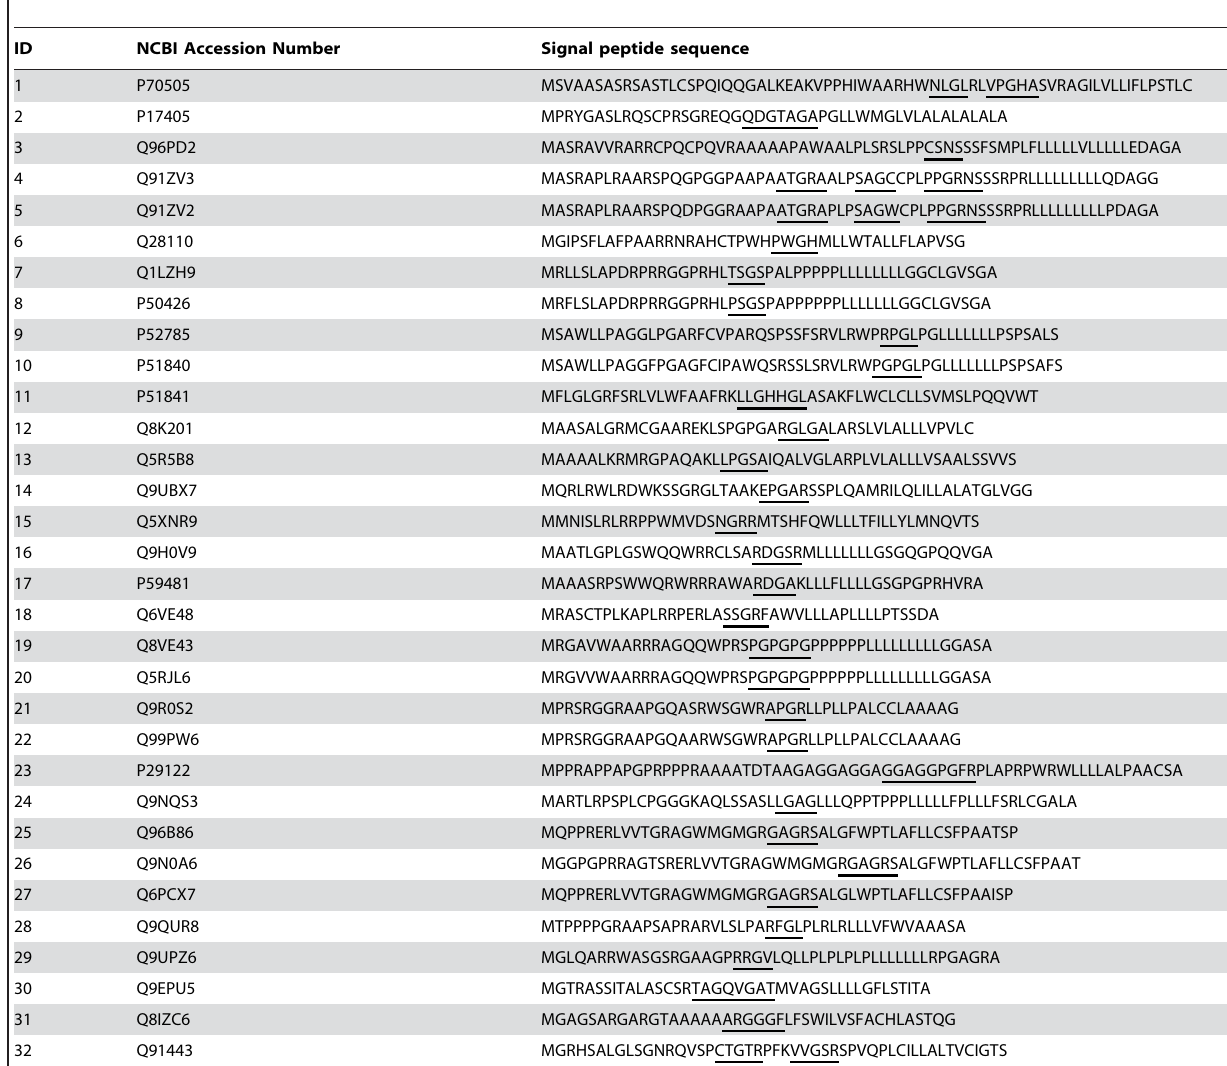
Table 1. 32 Vertebrate signal peptides . 40 amino acids, which are predicted to be NtraC organized and are similar in their domain capacity to